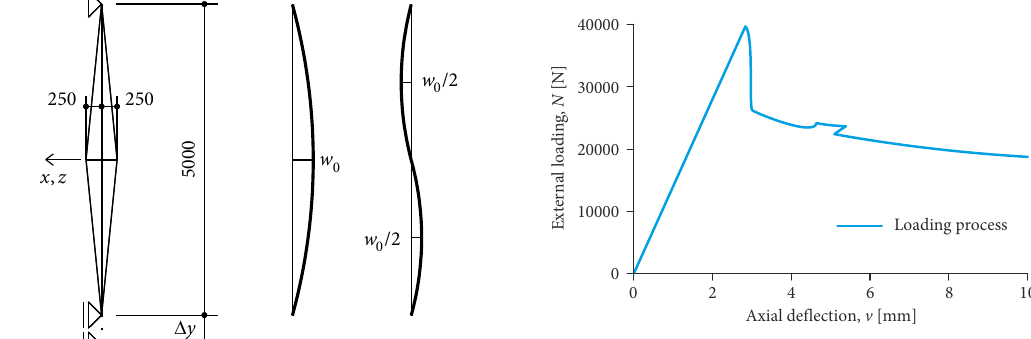
Fig. 4. Initial deflections (symmetrical and antisymmetrical mode, left) and a load-deflection path for optimal prestressing